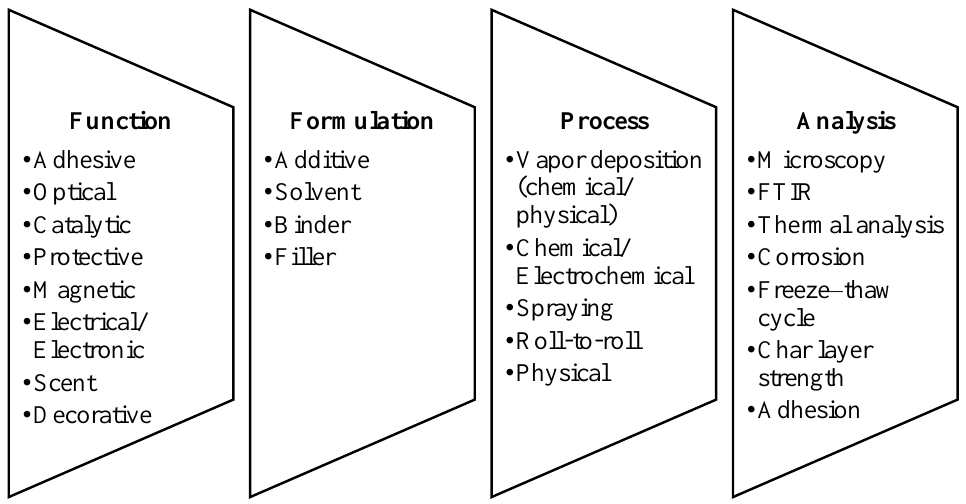
Figure 1. Coating details and categories based on function, formulation, process, and analysis.